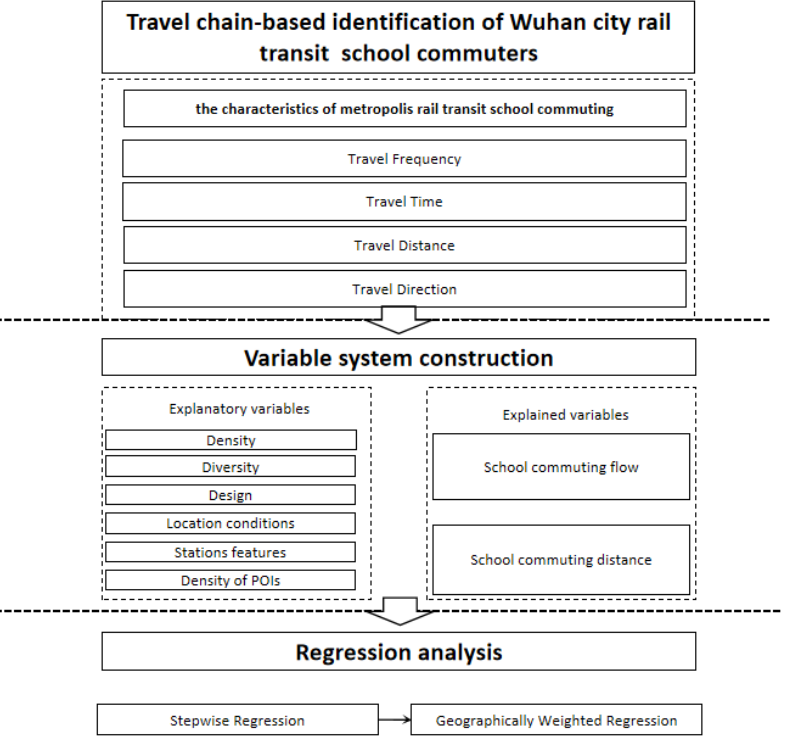
Figure 2. Technology route. POIs: Point of Interests.